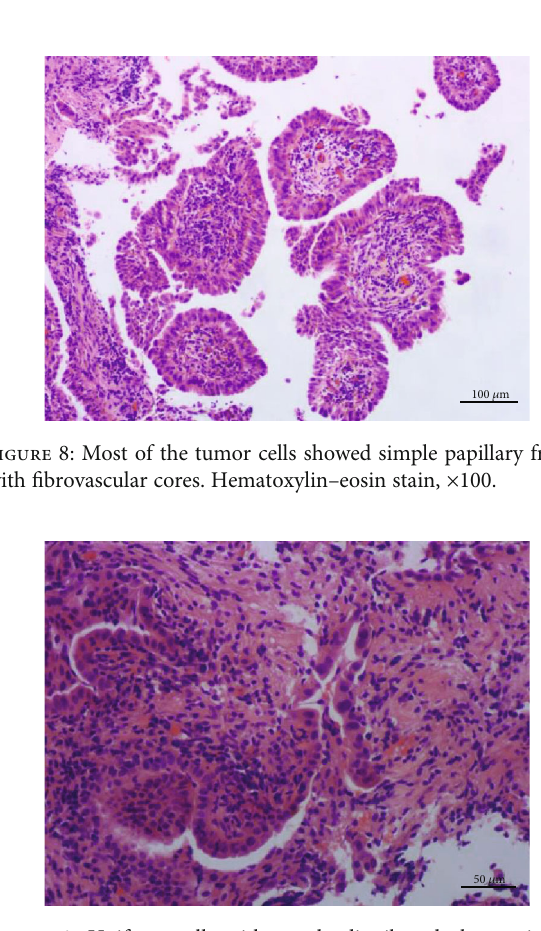
Figure 9: Uniform cells with evenly distributed chromatin and heteromorphic cells nearby. Hematoxylin – eosin stain, × 200.